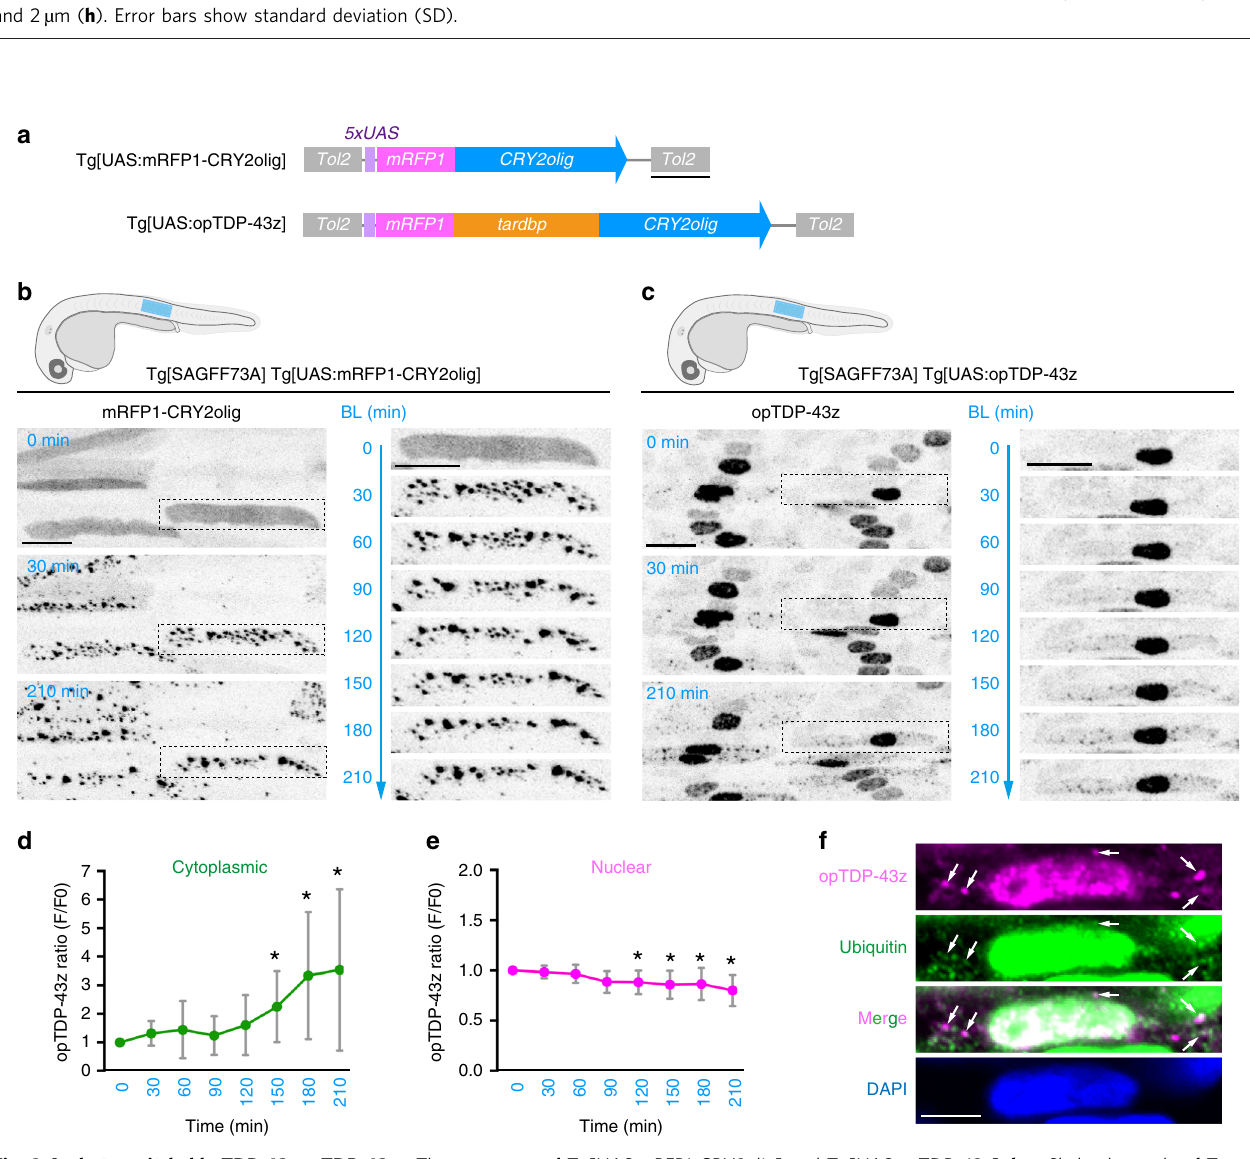
Fig. 2 A photo-switchable TDP-43: opTDP-43. a The structures of Tg[UAS:mRFP1-CRY2olig] and Tg[UAS:opTDP-43z]. b , c Skeletal muscle of Tg [SAGFF73A] Tg[UAS:mRFP1-CRY2olig] and Tg[SAGFF73A] Tg[UAS:opTDP-43] fi sh from 28 hpf (0 min) to 31.5 hpf (210 hpf). The blue light was illuminated from 0 to 210 min. Montages of single skeletal muscle cells expressing mRFP1-CRY2olig and opTDP-43z (dashed boxes) are shown on the right. d , e The averaged change of opTDP-43z intensity in the cytoplasm ( d ) and nucleus ( e ) of skeletal muscle cells in Tg[SAGFF73A] Tg[UAS:opTDP- 43z] fi sh during the illumination ( N = 8 cells from the same animal). Error bars show SD, and the center of the error bars is the mean. The asterisks indicate the statistically signi fi cant change in opTDP-43z fl uorescence intensity at each time point in comparison to the opTDP-43z level at t = 0, and adjustments were not made for multiple comparisons. In d p = 0.0125, 0.010, 0.0234 at 150, 180, 210 min, respectively (unpaired t -test, two-tailed). In e p = 0.0092, 0.0128, 0.0114, 0.0311 at 120, 150, 180, 210 min, respectively. f Immuno fl uorescence of the skeletal muscle of fi sh illuminated for 3.5 h, using anti-RFP (for opTDP-43z) and anti-ubiquitin antibodies. Arrows indicate the representative of opTDP-43z foci that are partially ubiquitinated. The bars indicate 500 bp ( a ), 20 µ m ( b , c ), and 5 µ m ( f